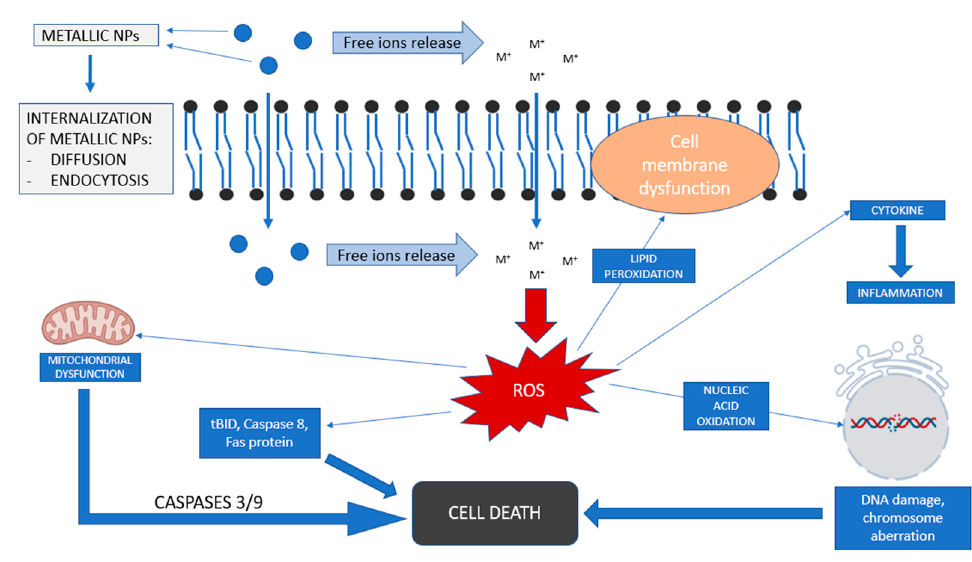
Figure 2. General view of toxicity mechanisms of metallic nanoparticles (based on [59,60]).